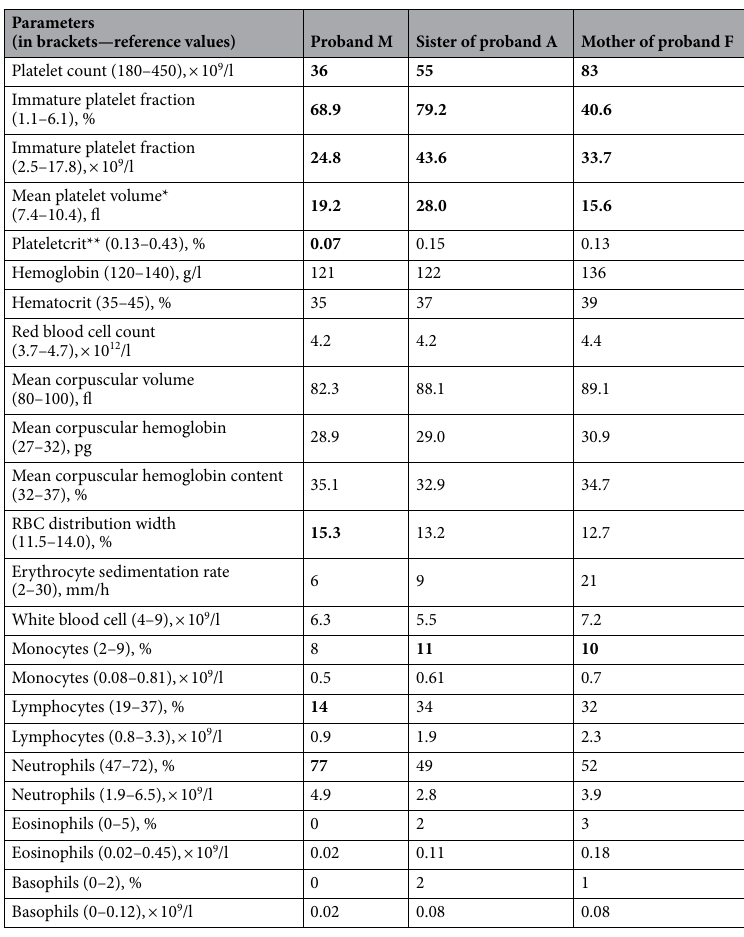
Table 1. Hemogram in the patients with a MYH9 gene mutation examined. The numbers in bold are outside the corresponding reference range. *Calculated manually based on the size distributions of platelets (Fig. 3D– F). **Calculated manually using the individual mean platelet volumes and platelet